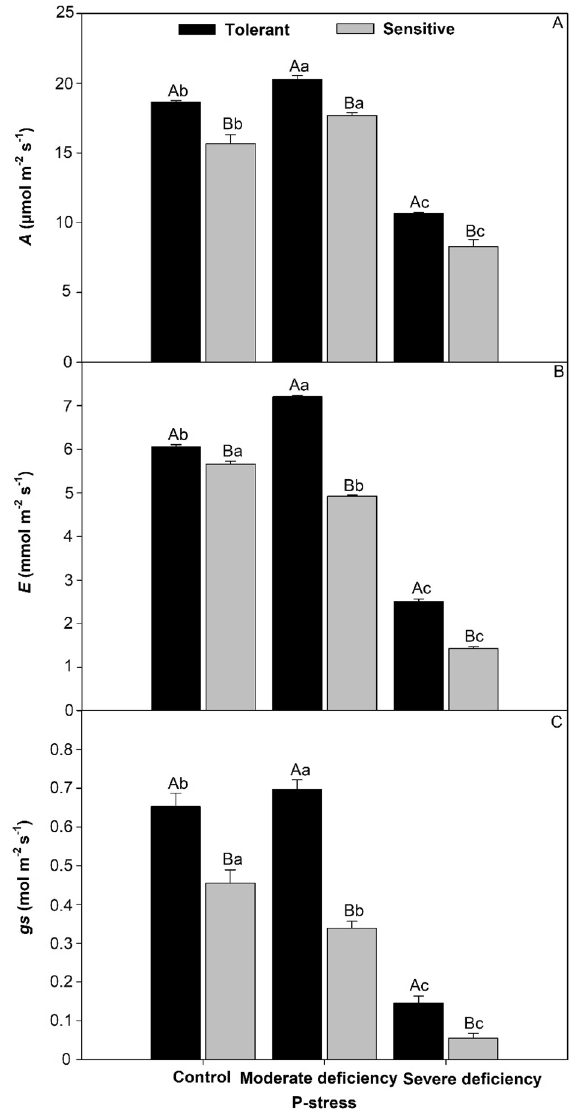
Figure 6. Net assimilation ( A ), transpiration rate ( B ), and stomatal conductance ( C ) in cultivars tomato treated P-stress. Columns with different capital letters compare cultivars (tolerant and sensitive) between P stress levels (control, moderate deficiency, and severe deficiency). Lowercase letters compare cultivars (tolerant and sensitive) with the same color as a function of P stress levels (control, moderate deficiency, and severe deficiency). Different letters differ by the Scott-Knott test (P < 0.05). Columns corresponding to means of six repetitions and standard